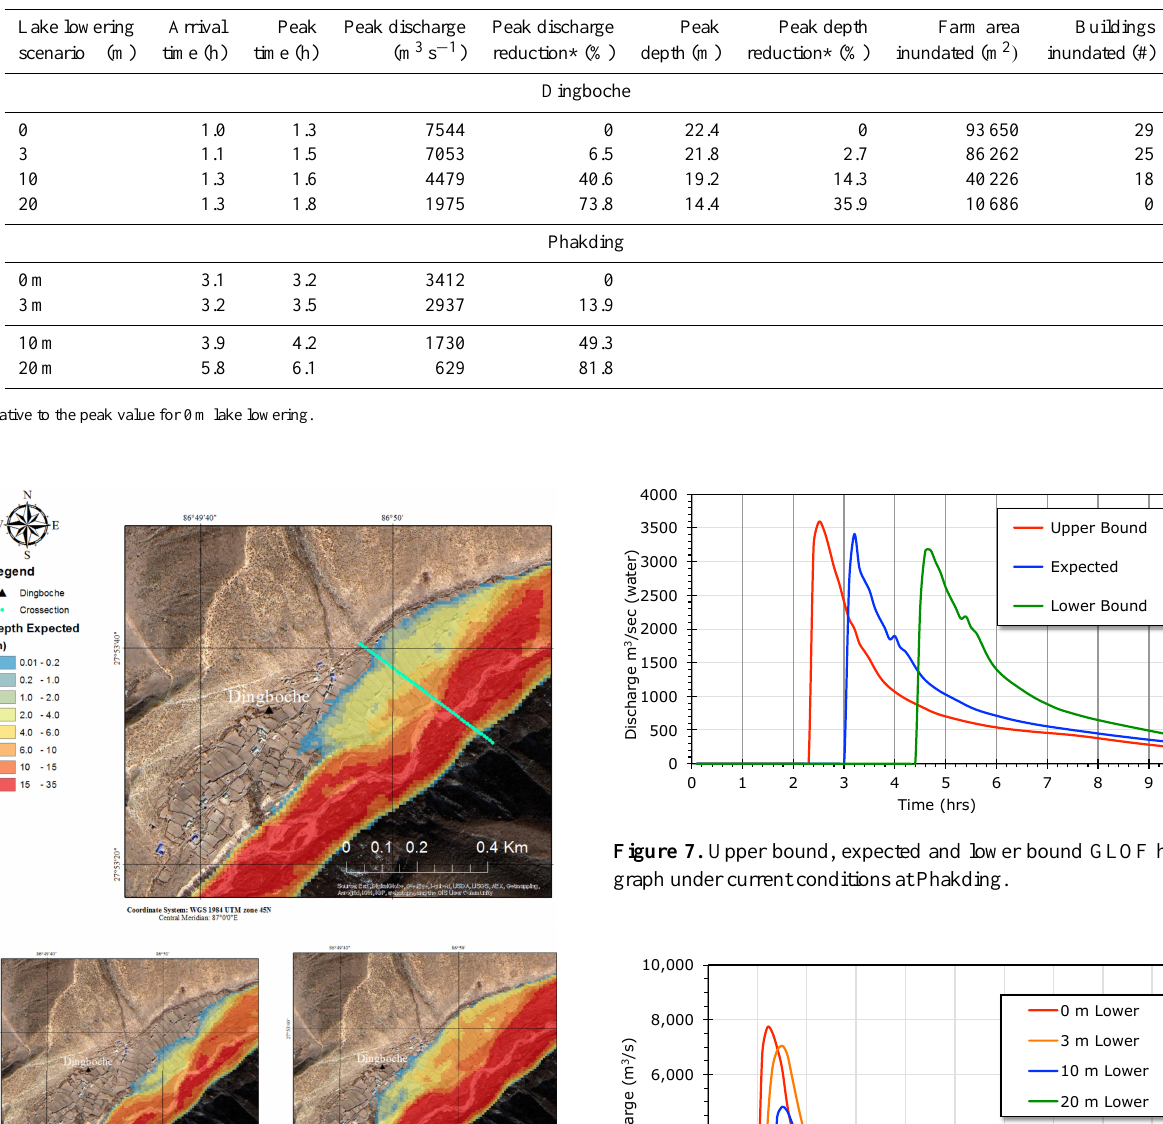
Figure 9. GLOF flood stage at Dingboche under current lake conditions for 0 m (Expected), 3 m, 7 10 m and 20 m lake lowering scenarios. 8